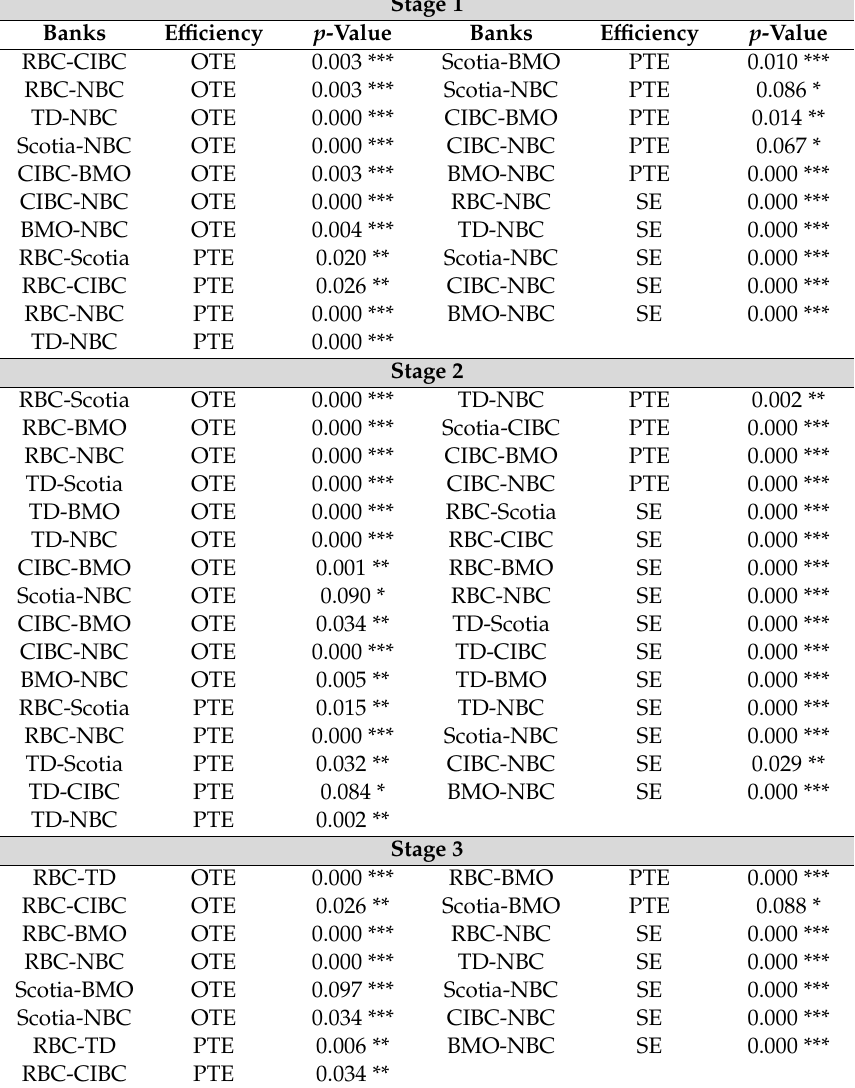
Table 7. The results of pairwise t -test for